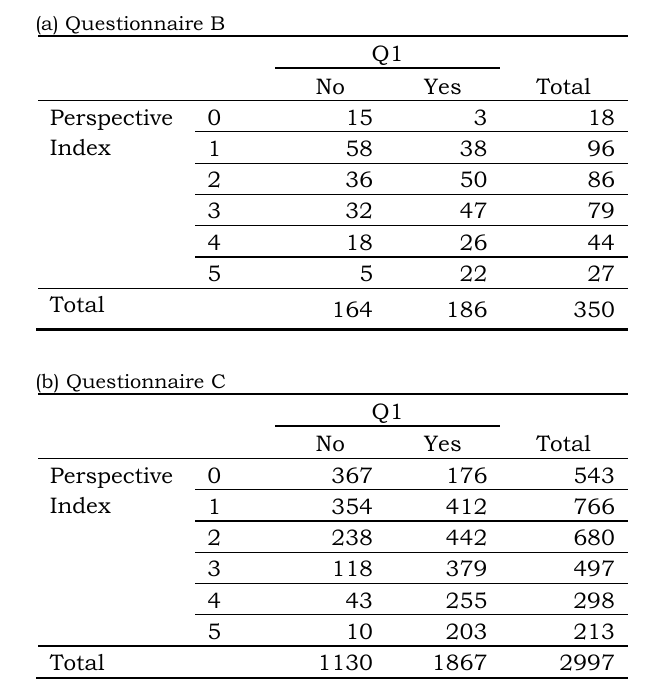
Table 3. Cross-table of the perspective index and job